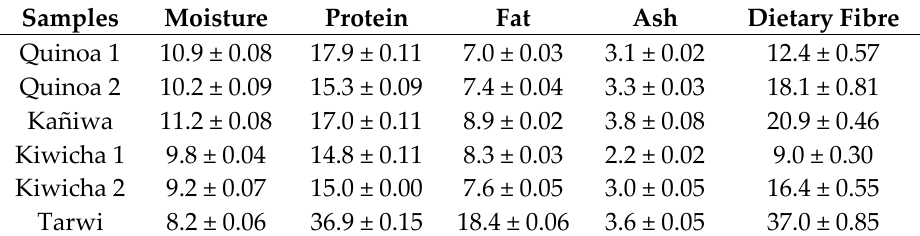
Table 1. Chemical composition of Andean grains (g/100 g).